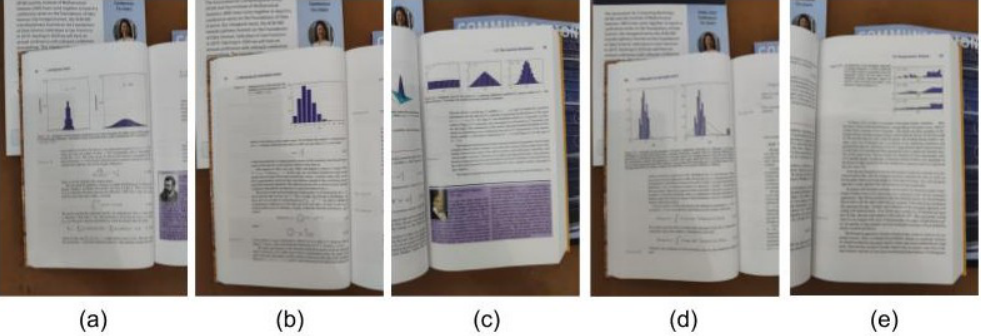
Figure 5. Bar chart photographs taken from a book [1] and transformed for evaluation. ( a , d ) present two bar charts with text, ( b ) shows one bar chart, and ( c , e ) present three bar charts. For this evaluation, the detector considers only the most accurate detection.